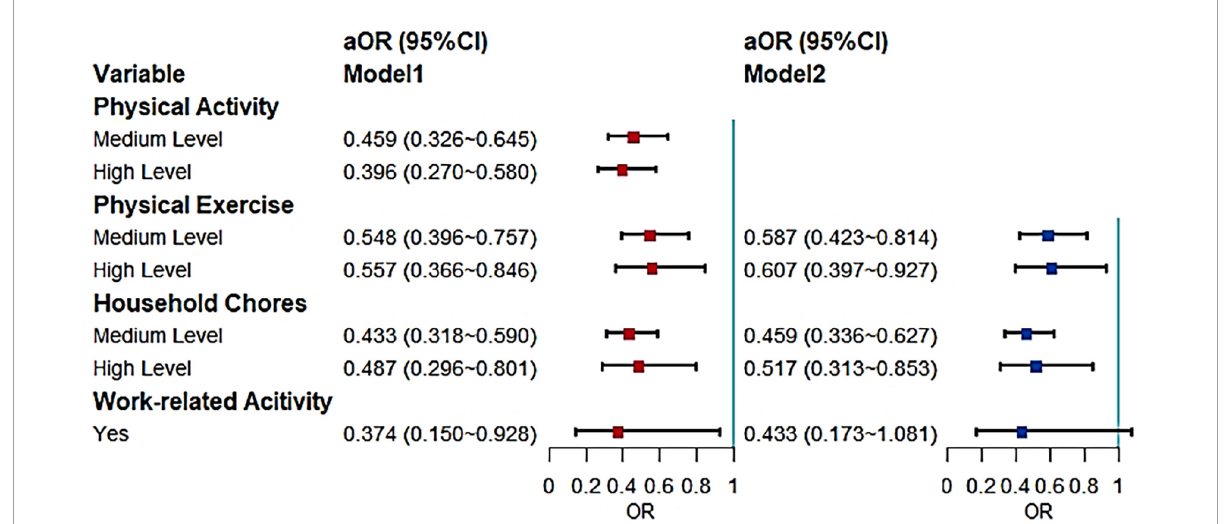
FIGURE2 Effects of different types of physical activity on MCI (aOR, adjusted odds ratio; Use the low level and negative response as the